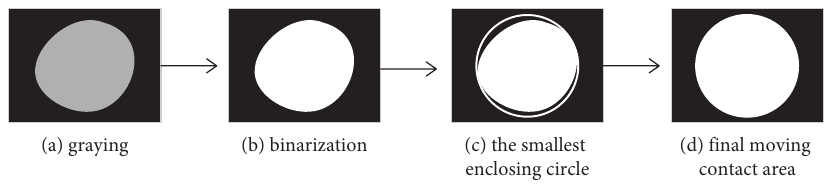
Figure 5: Image preprocessing.